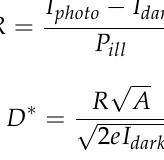
Table 3. Parameters of photodetectors on the basis of Zn 1 − x Mg x O films.